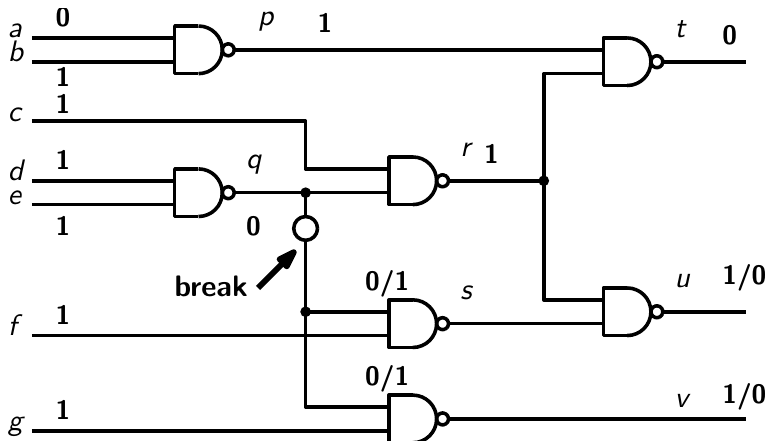
Figure 5. Example showing a broken interconnection that results in logic errors in two fan-out branches out of